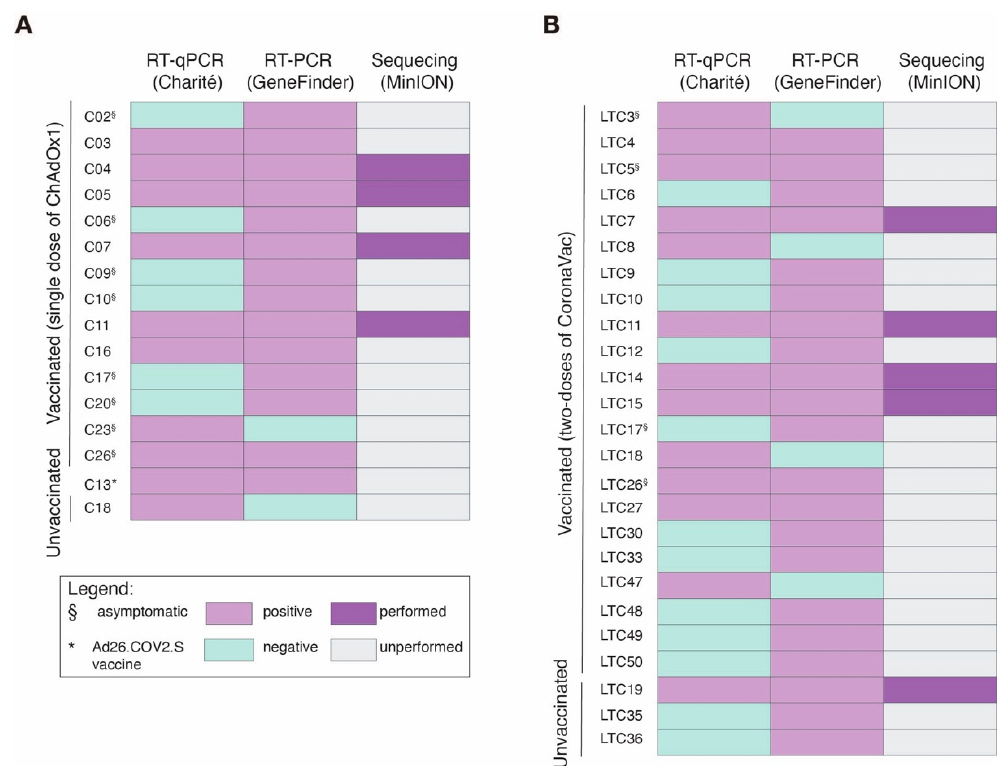
Figure 2. Diagnosis of SARS-CoV-2 cases from outbreaks described in this study. Outbreak A in convent ( A ), and outbreak B in long-term care facility ( B ). Abbreviations: RT-qPCR; real-time quantitative polymerase chain reaction; C, convent; LTC, long-term care facility.